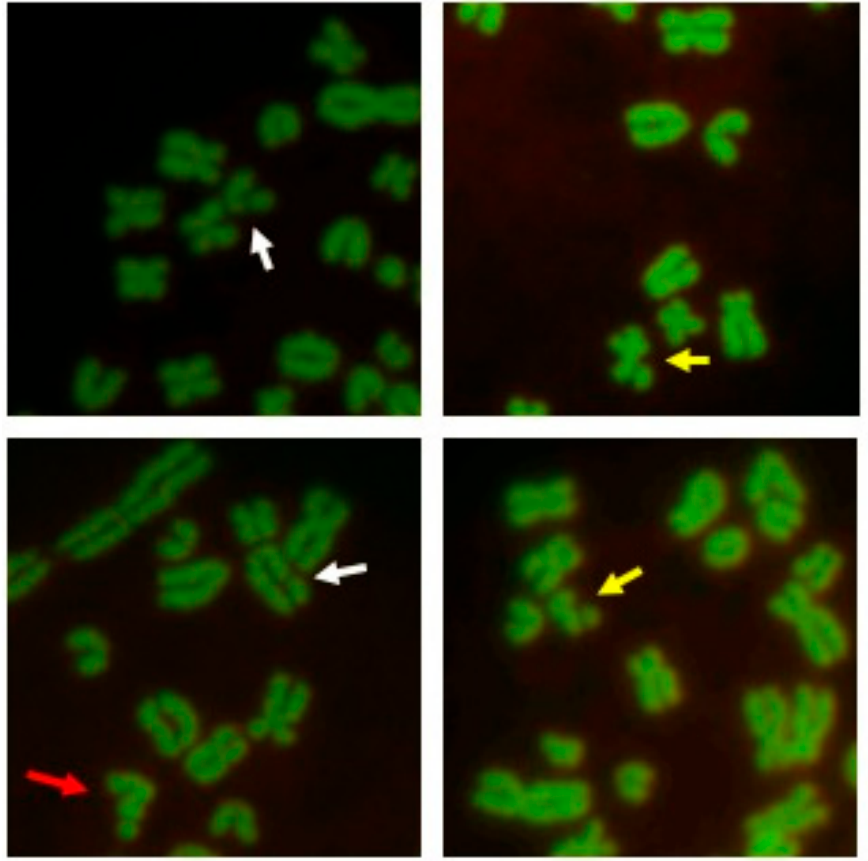
Figure 2. Details of chromosome metaphase plates of Pony of Esperia. The white arrow indicates a gap, the yellow arrow indicates a chromatid break, and the red arrow indicates a chromosome break.